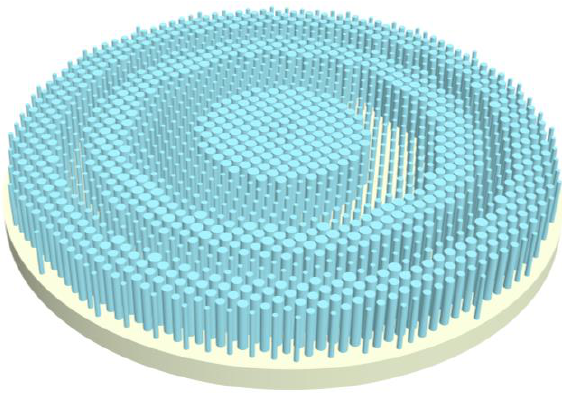
Figure 1. Schematic structure of the metalens.